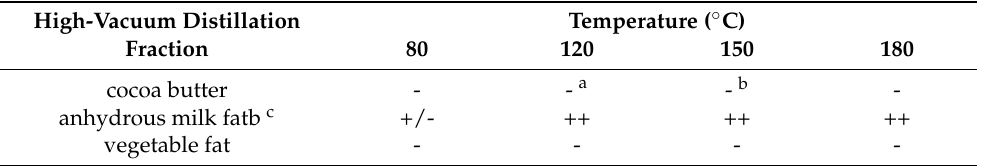
Table 1. Enhancement of creamy flavor by adding the semi-volatile isolate obtained by high- vacuum distillation of cocoa butter (CCB), anhydrous milk fat (AMF), and vegetable fat (VF) at 80/120/150/180 ◦ C. The isolates were suspended in